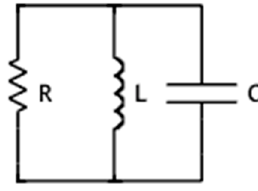
Figure 6. Equivalent circuit of planar antenna [16].